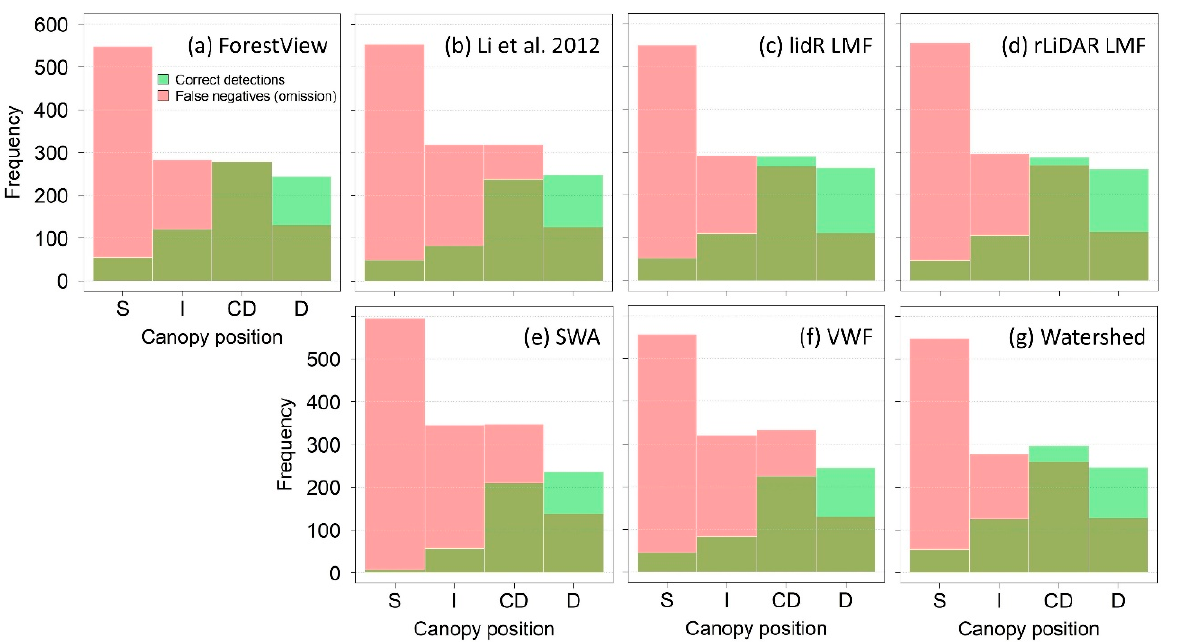
Figure 2. Correct detection and false negative (omissions) distributions by canopy position for the seven most accurate ITD method approaches derived from the 8 ppm 2 ALS dataset (highlighted in Table 4). Dark-green coloration indicates where the two distributions overlap. Canopy positions are as follows: S = suppressed, I = intermediate, CD = codominant, D = dominant. The method shown in ( b ) refers to [19].